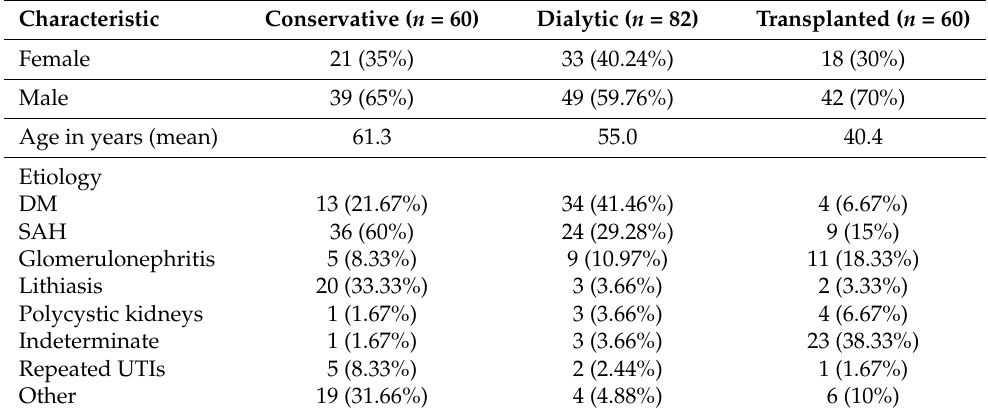
Table 1. Epidemiological characterization of the sex, age, and etiology of chronic kidney disease patients from the conservative, dialysis, and transplanted groups in Bel é m, Par á